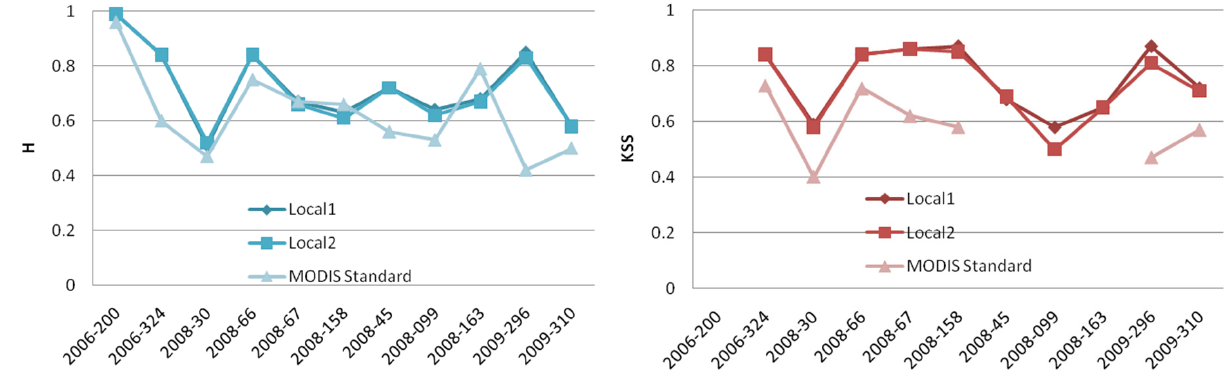
(Local2) and with the MODIS standard cloud masks (MODIS